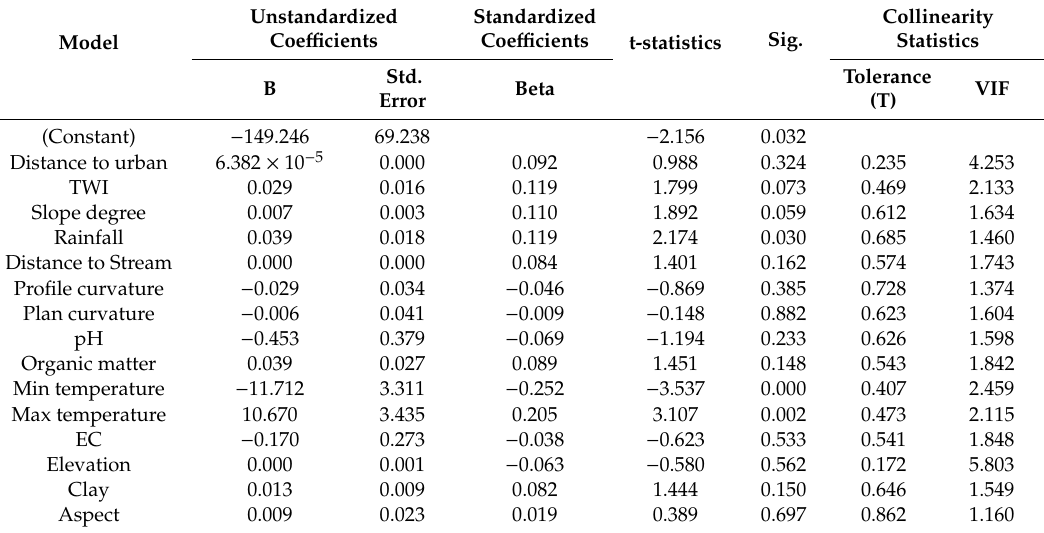
Table 2. Multicollinearity of the e ff ective factors in the study area.